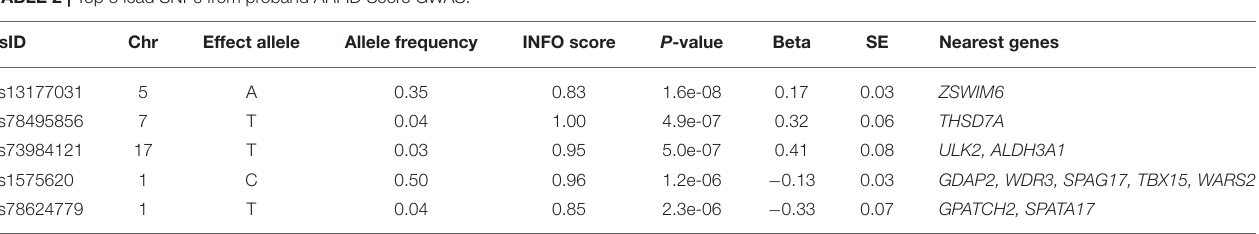
TABLE 2 | Top 5 lead SNPs from proband ARFID Score